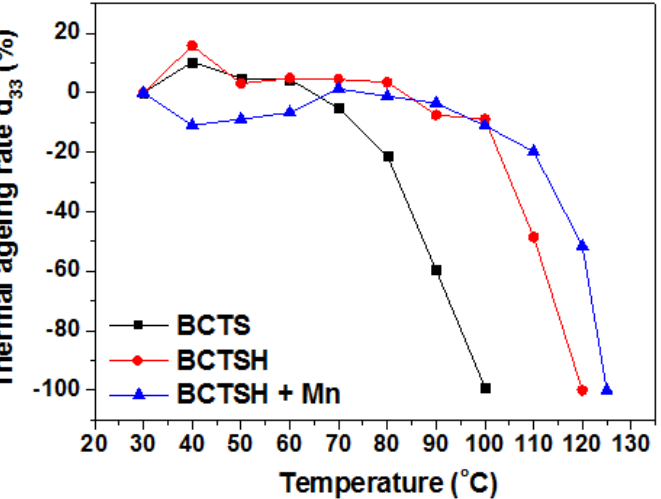
Figure 5. Temperature stability measurement for the thermal aging d 33 of BCTS, BCTSH and BCTSH + Mn